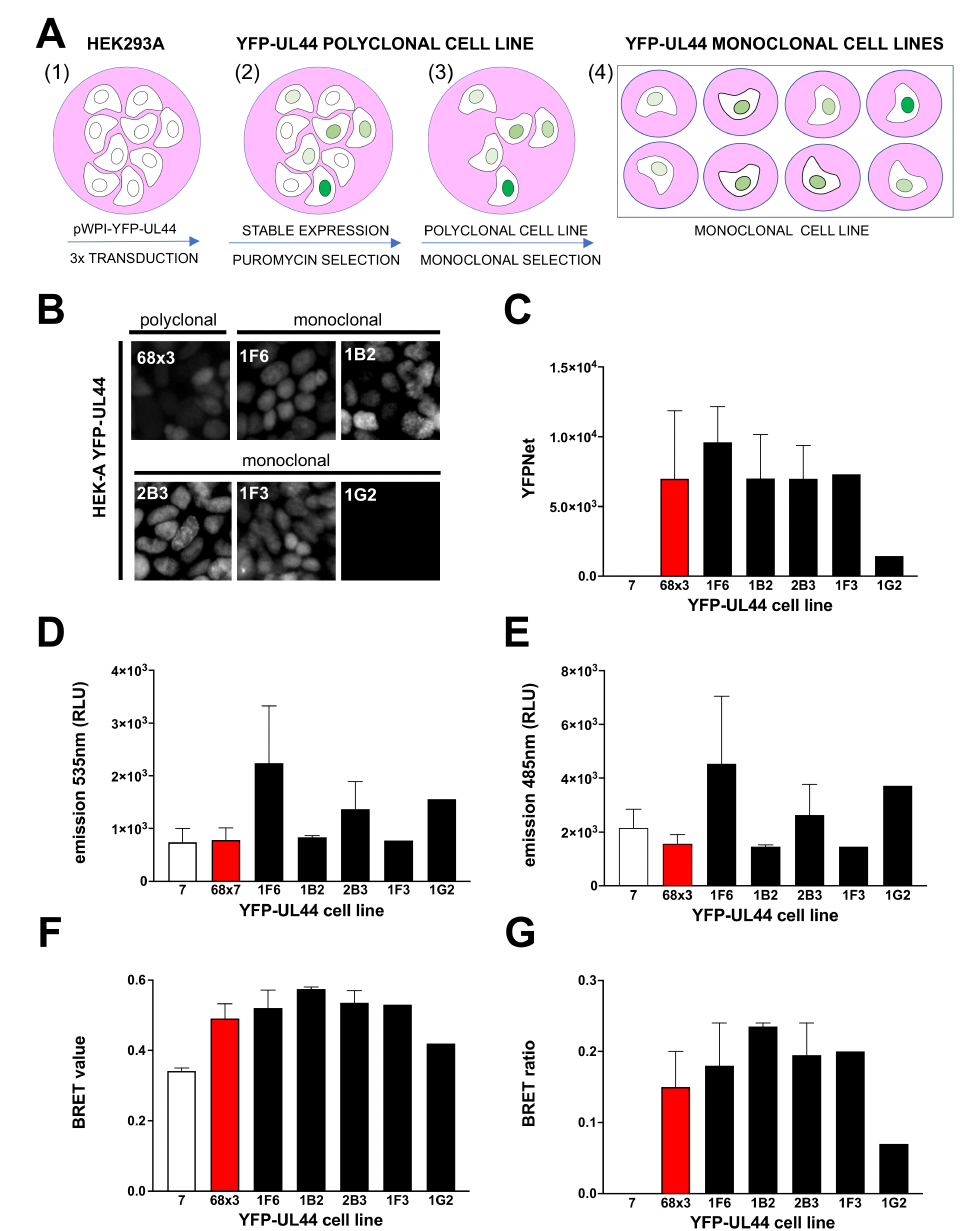
Figure 5. Establishment of polyclonal and monoclonal cell lines stably expressing different levels of YFP-UL44 for BRET assays. ( A ) HEK293A cells were seeded in 6-well plates and, starting 24 h later, were sequentially transduced 1, 2 or 3 times with Lentiviral particles containing either pWPI-puro or pPWI-YFP-UL44-puro (1). Transduced cells were selected with puromycin (2) and expanded to generate stable cell lines (3). The latter were diluted to single cells in 96-well plates and expanded to generate monoclonal cell lines (4). YFP-UL44 subcellular localization was microscopically evaluated ( B ), whereas its expression levels were quantified by fluorimetry ( C ). Upon transfection with 25 ng of pDESTnRLuc-UL44 and addition of coelenterazine, the indicated cell lines were evaluated for 535 ( D ) and 485 ( E ) nm emission, allowing to calculate their respective BRET values ( F ) and BRET ratios ( G ). Cells were subsequently seeded in 96 well plates at 0.5/cells well in order to obtain monoclonal cell lines (Figure 5A, panel 4), which were further expanded. All cell lines were regularly monitored for YFP-UL44 fluorescence intensity using an inverted fluorescence microscope. Twelve cell clones expressing different levels of YFP fluorescence were selected for further analysis. Our analysis revealed that while the polyclonal cell line exhibited